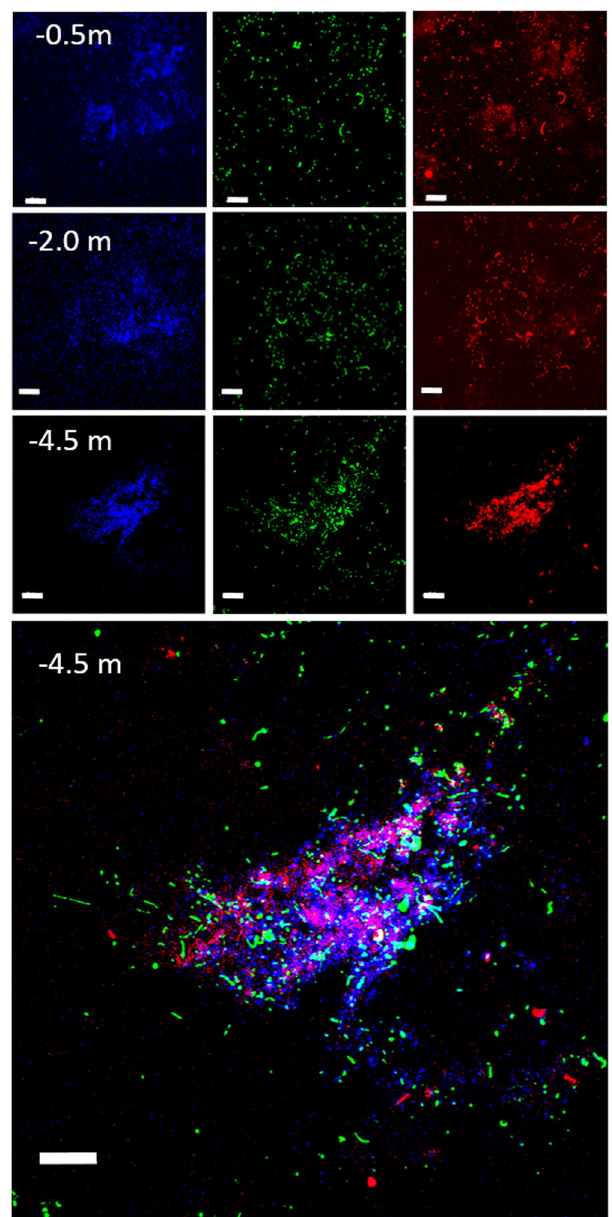
Fig. 6 CLSM combined images showing microbial aggregates at 3 different depths. DAPI stained cells (blu), bacterial cells identi fi ed by CARD-FISH (green); auto fl uorescent Cyanobacteria (red). Lowest panel shows the overlap of three images (Bars = 20 μ